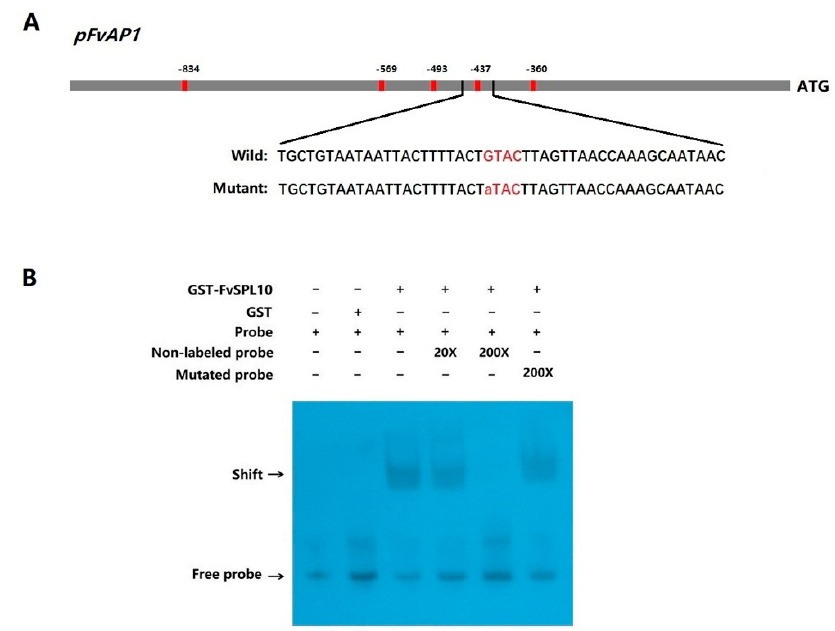
Figure 3. Electrophoretic mobility shift assay (EMSA) verification the binding capability of FvSPL10 . ( A ) Schematic diagram of the FvAP1 promoter ( − 1000 bp upstream from the start codon) and probes used for EMSA. The five red bars represent the five GTAC motifs in the promoter and the number represents the position of these motifs in the promoter. A total of 47 bp oligonucleotides containing the second GTAC motif was selected as the probe. The mutant probe was the same as the wild-type probe except G substituted by A in the GTAC motif. ( B ) Binding of FvSPL10 to the promoter of FvAP1 in EMSA. The biotin-labeled probes were incubated with purified GST or GST-FvSPL10 fusion protein to detect the binding ability, and the unlabeled or mutant probes were used as competitors to test the binding specificity of FvSPL10 . Formed DNA-protein complexes were separated by native polyacrylamide gel. Arrows indicate the position of the shifted bands and free probes, respectively.